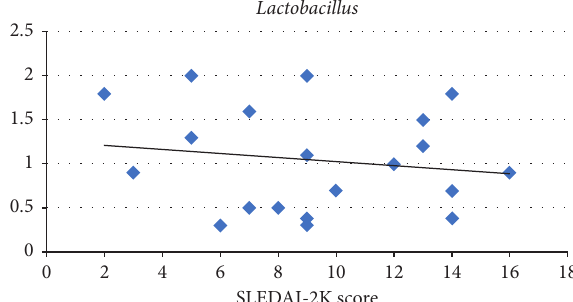
Figure 4: Negative correlation between SLE disease activity and Lactobacillus